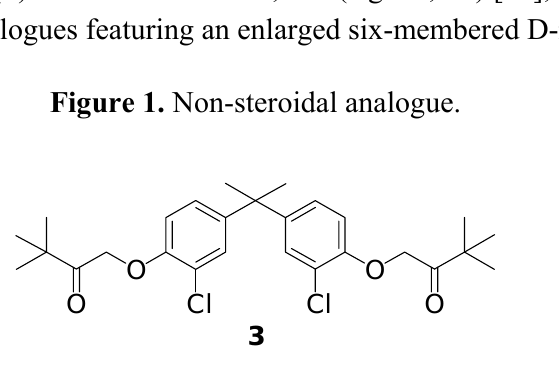
Figure 2 . Structural modifications in calcitriol